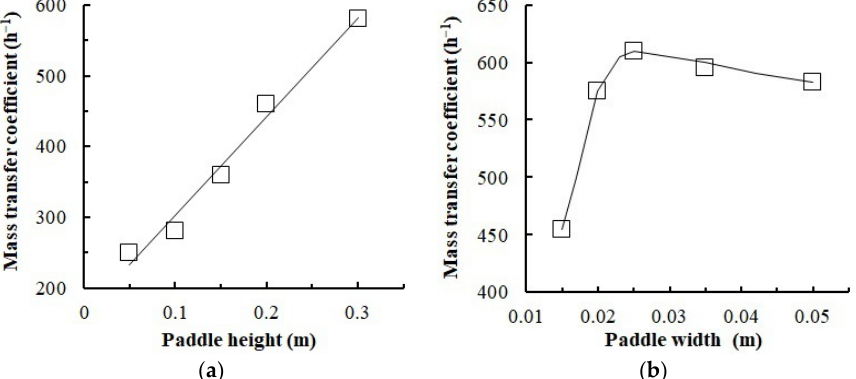
Figure 16. The dependence of the mass transfer coefficient on the height ( a ) and width of the paddle ( b ) at H L / D = 1.2, n = 1400 (rpm), D = 0.28 (m), one partition. Thus, to generate gas–liquid dispersion in the tank according to the schematic diagram presented in Figure 1d, reducing the stirring power requires the minimum number of partitions to be installed inside the tank. In the region of intensive dispersion at 1200– 2400 rpm and gas content 0.15–0.2, the power criterion calculated taking into account the gas content was K N = 4–5.